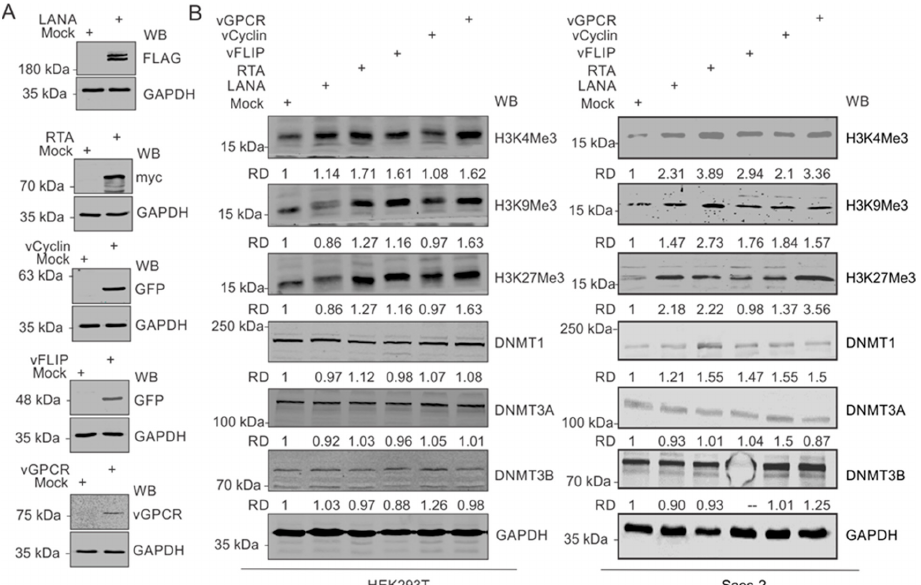
Figure 3. KSHV ‐ encoded genes mediate the upregulation of modified histone proteins. ( A ) Representative image for the confirmation of ectopic expression of KSHV ‐ encoded genes in HEK293T cells. ( B ) (Left panel): Western blot analysis for the expression of HEK4Me3, H4K9Me3 H3K27Me3, DNMT1, DNMT3A, and DNMT3B in HEK293 cells expressing KSHV ‐ encoded LANA, RTA, vCyclin, or vGPCR proteins: 48 h post ‐ transfection, cells were lysed, and equal amounts of whole ‐ cell lysate were electrophoresed on polyacrylamide gels followed by transfer to nitrocellulose membrane. Expression levels of HEK4Me3, H4K9Me3, and H3K27Me3 were monitored by Western blot analysis using specific antibodies against respective proteins. GAPDH served as a loading control. (Right panel): Western blot analysis for the expression of HEK4Me3, H4K9Me3, and H3K27Me3, DNMT1, DNMT3A, and DNMT3B in Saos ‐ 2 cells expressing KSHV ‐ encoded LANA, RTA, vCyclin or, vGPCR protein levels: 48 h post ‐ transfection, cells were lysed, and equal amounts of whole ‐ cell lysates were electrophoresed on polyacrylamide gel followed by transfer to nitrocellulose membrane. Expression levels of HEK4Me3, H4K9Me3, and H3K27Me3, DNMT1, DNMT3A, and DNMT3B were monitored by Western blot analysis using specific antibodies against respective proteins. GAPDH served as a loading control.